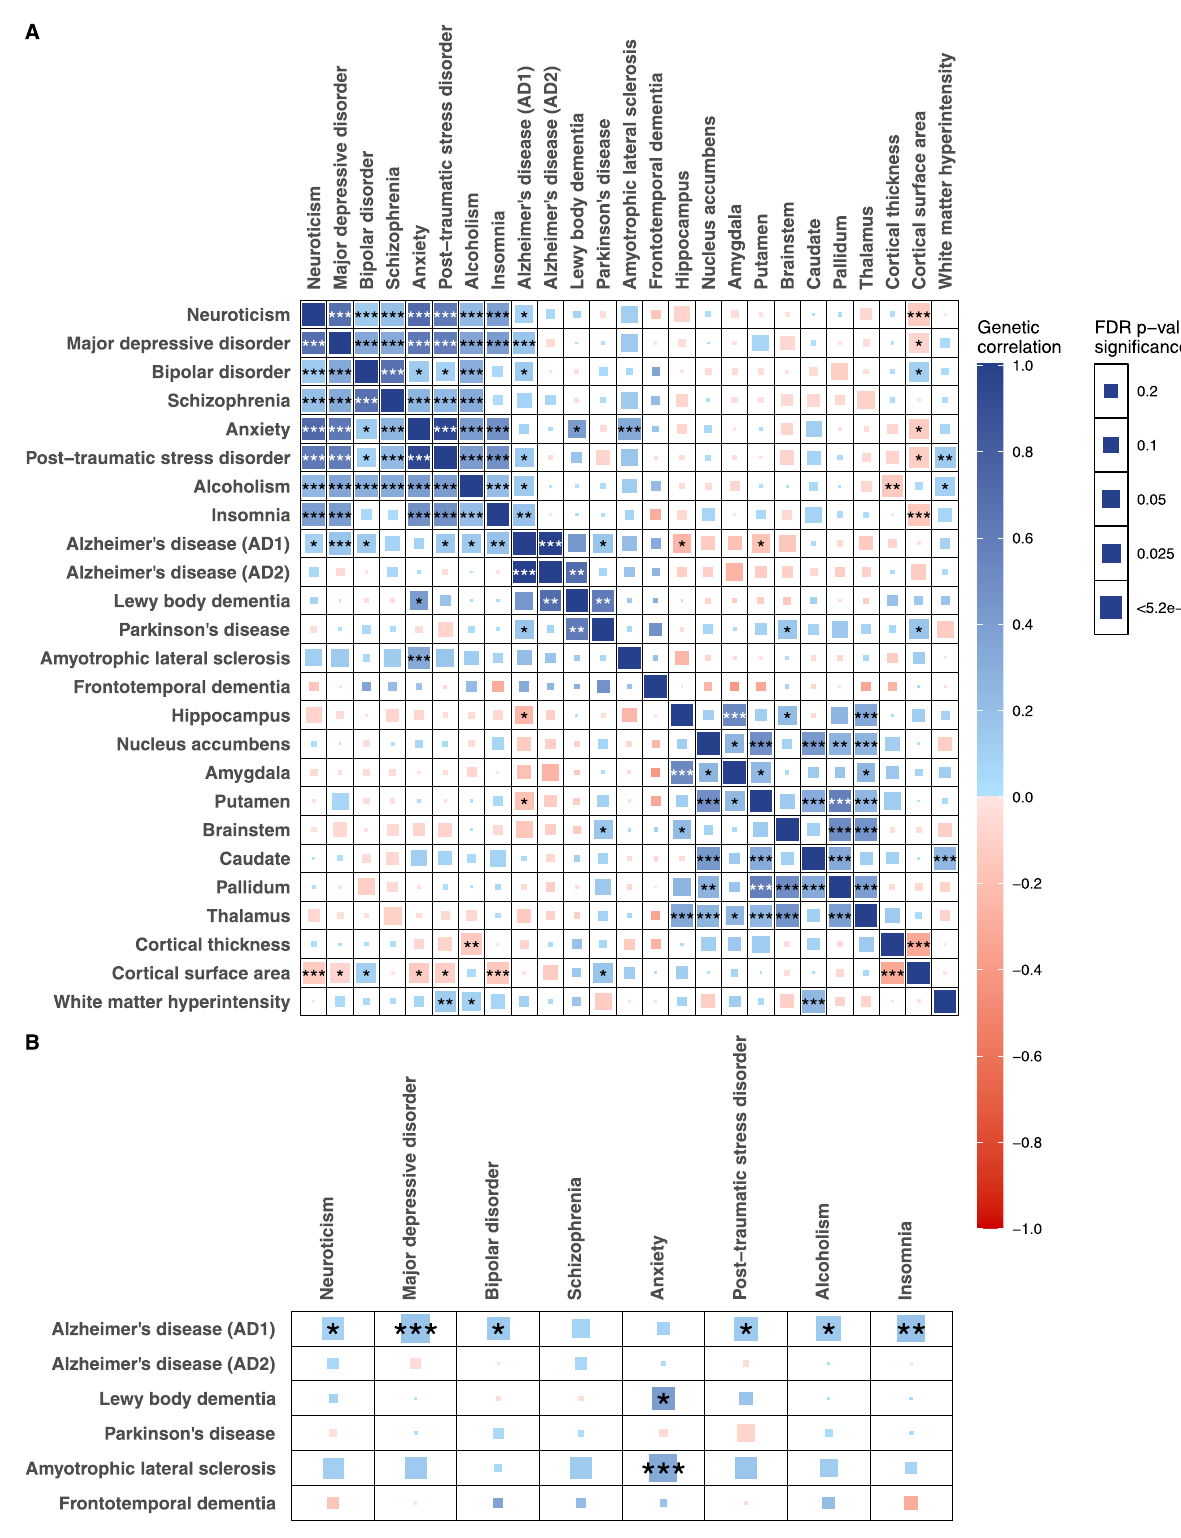
Fig. 2 | Genetic correlations across brain structures, psychiatric, and neuro- degenerative diseases. A Pairwise genetic correlations among the 24 brain traits using LD score regression. B Genetic correlations between the psychiatric and neurodegenerative traits based on LD score regression. The color denotes the